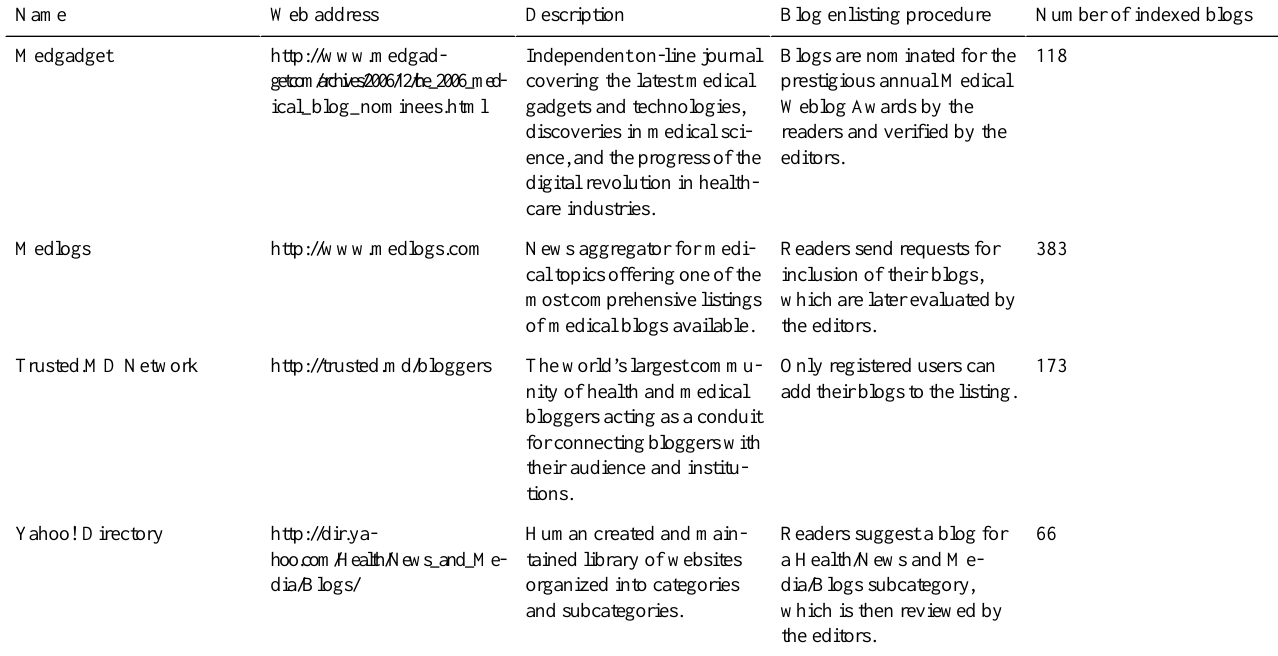
Table 1. Characteristics of the websites used to identify medical bloggers and data about number of indexed blogs on February 10, 2007